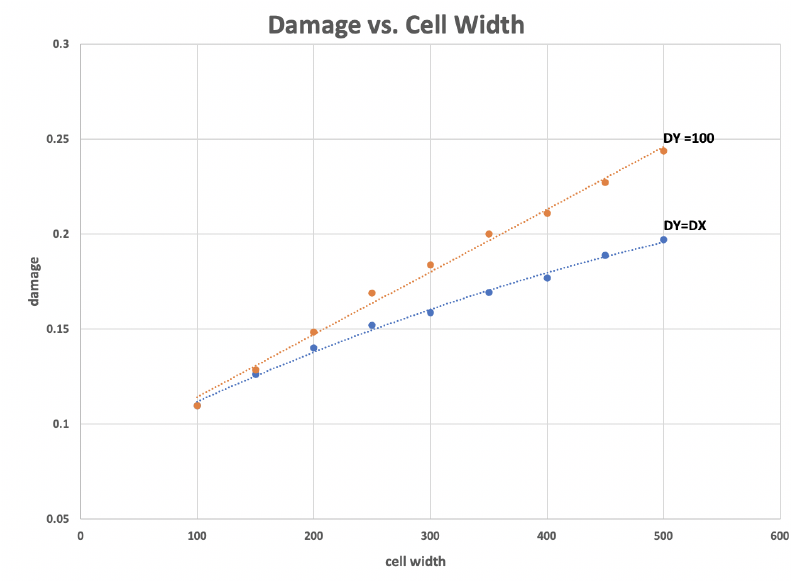
Figure 7. Damage at time of failure is plotted as a function of the cell width DX . The strain rate for all points is ˙ ϵ = 1 × 10 5 s − 1 , the ensemble size is 100 and the process zones is 10% of the crack radius. In the upper curve, DY = 100 µ m for all points. In the lower curve, DY = DX . On both curves, wider cells support more damage at failure. Taller cells support less damage at